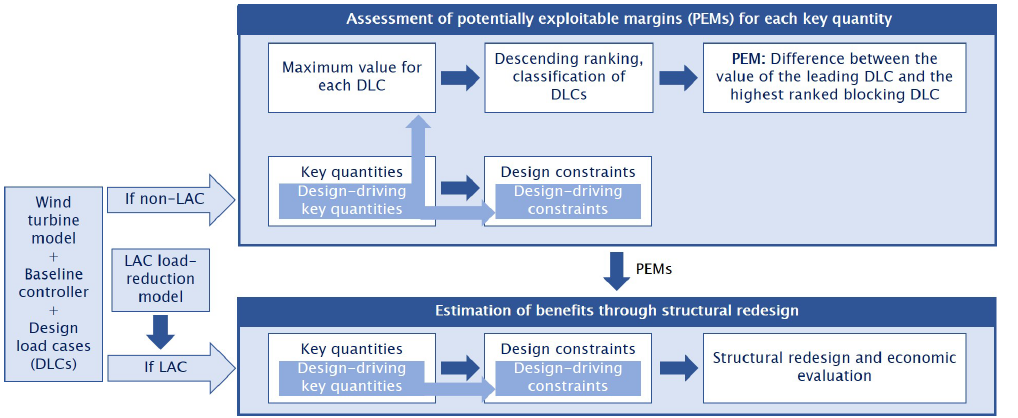
Figure 1. Approach